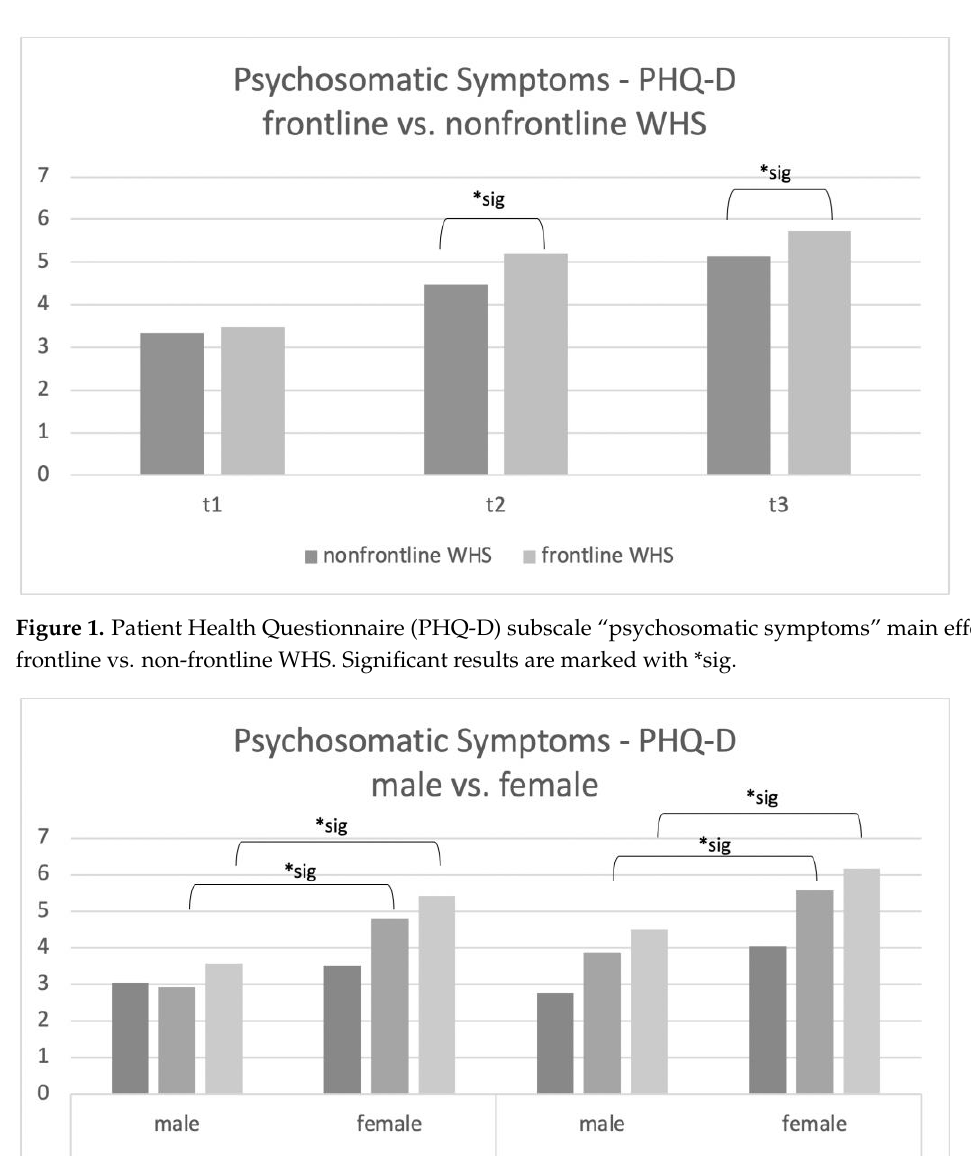
(main effect frontline vs. non-frontline WHS) and Figure 2 (main effect male vs. female WHS) for the results of the ANCOVAs. WHS) for the results of the ANCOVAs.